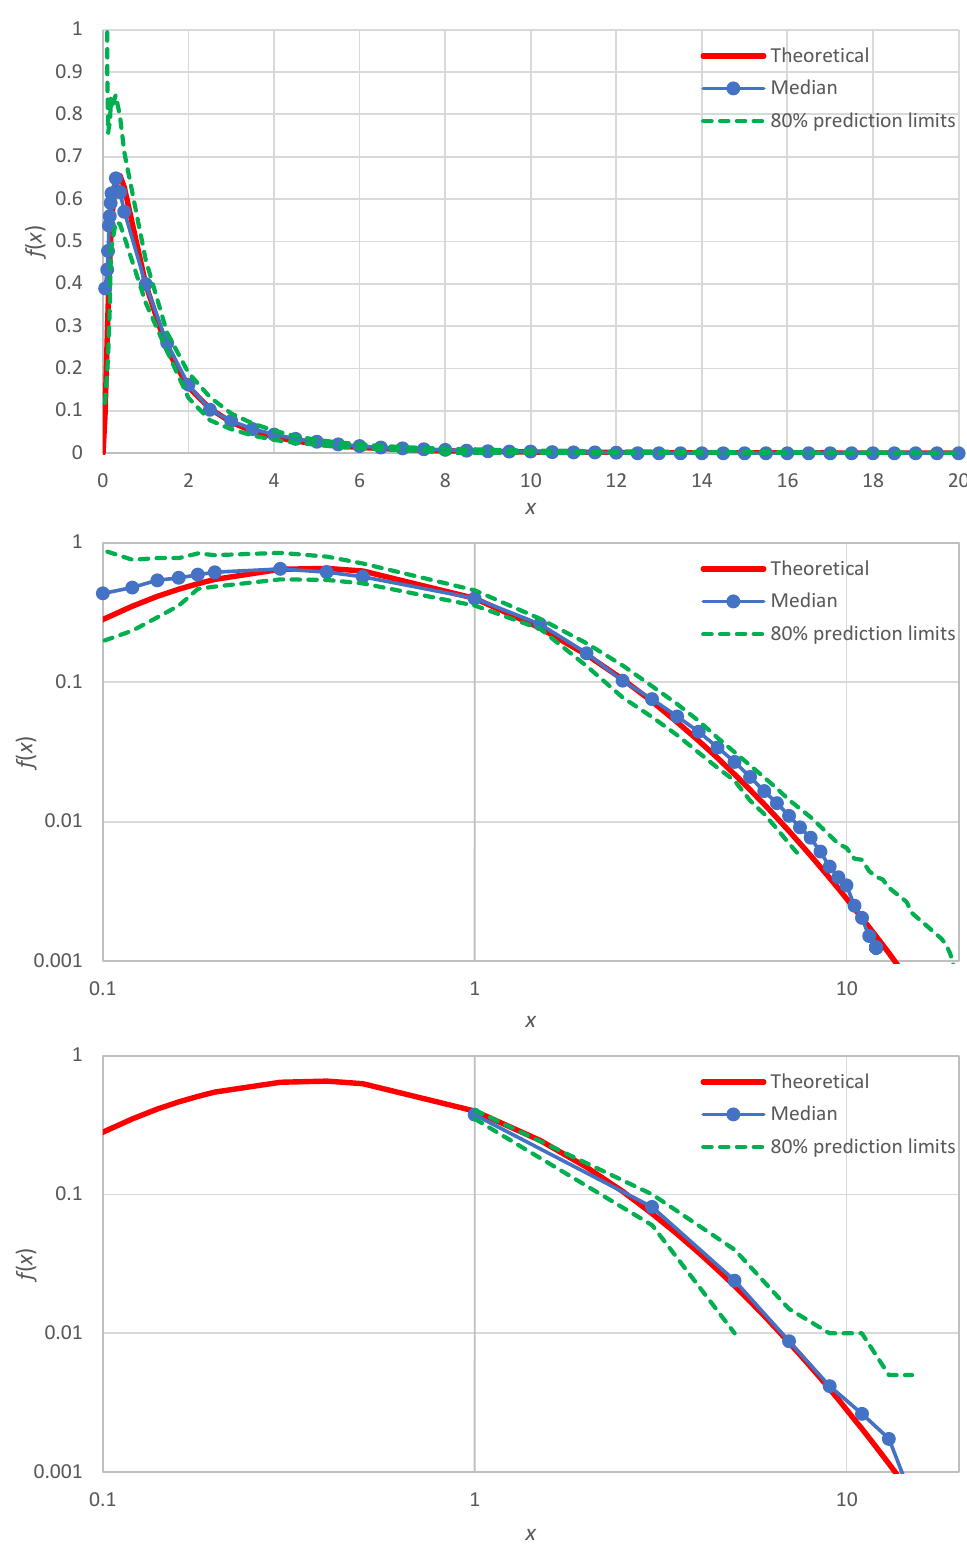
Figure 4. Illustration of the median estimate and uncertainty (in terms of prediction limits) of the probability density as in Figure 2 but for the lognormal distribution with parameters as in Table 4.